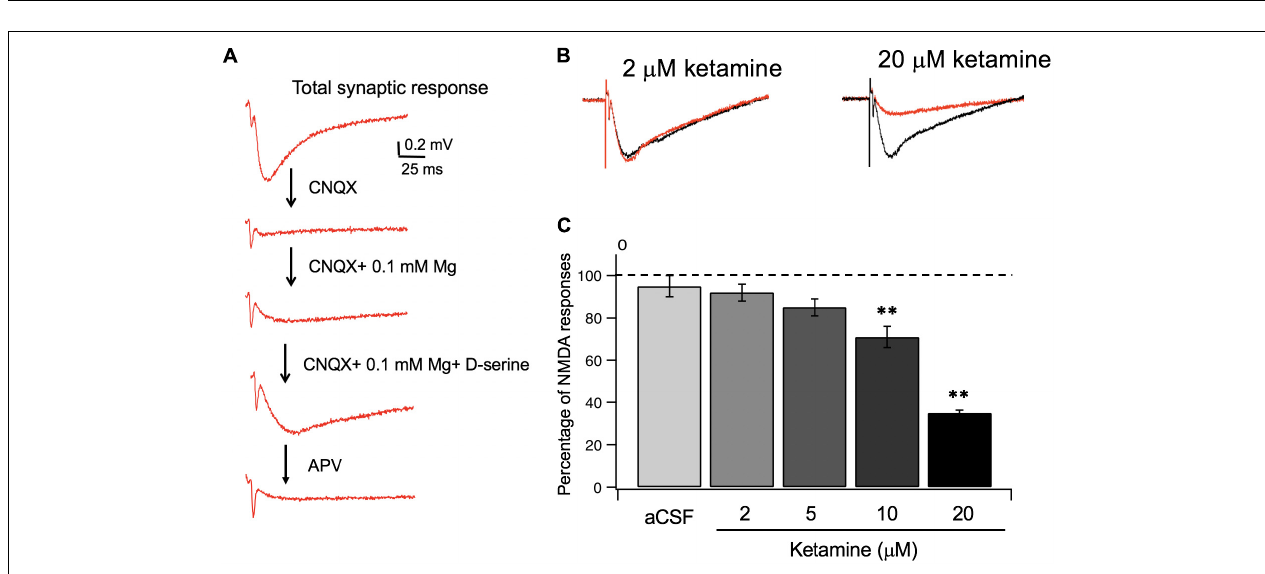
FIGURE 2 | (A) Calculated tissue concentration of ketamine (diffusion coefficient D = 12 µ m 2 s − 1 ) as function of depth and time within a 350 micron thick brain slice exposed on the top surface to a solution of ketamine in ACSF. The dotted line represents the average concentration of ketamine within the entire 350 micron thick slice as a function of time. (B) 3-D representation of the diffusion kinetics as a function of time and depth.